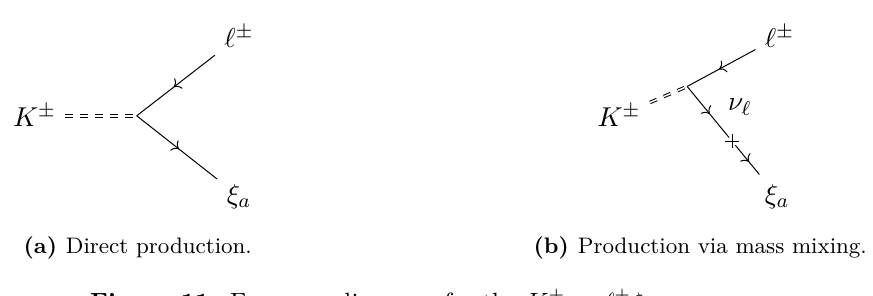
figure 11: i) diagrams with a single trilinear one-meson K ± → ‘ ± ξ directly couples χ PT to hidden sectors, and ii) diagrams with one trilinear K ± → ‘ ± ν